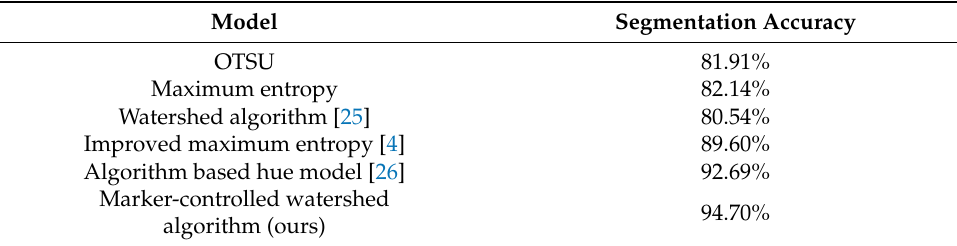
Table 3. Segmentation accuracy of long